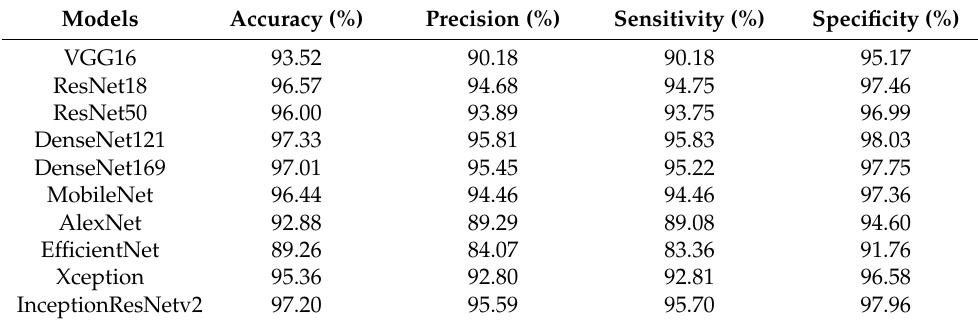
Table 9. Comparison of results on image classification with pre-training in the control group.